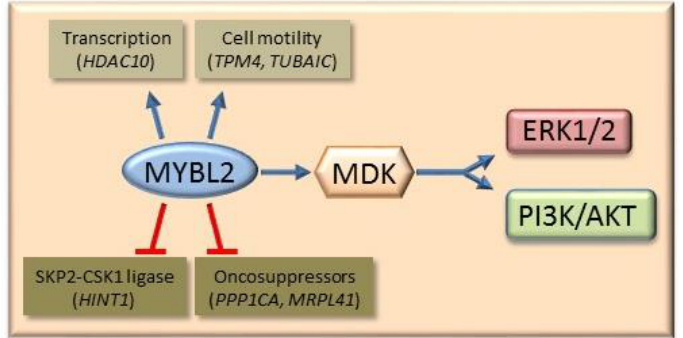
Figure 6. Oncogenic effect of MYBL2. MYBL2 activates different genes involved in DNA transcription, cell motility, and MDK (Midkine), an activator of PI3K/AKT and ERK1/2 pathways. Furthermore, MYBL2 inhibits of the SKP2-GSK1 ubiquitin ligase (Hint 1) and the oncosuppressors PPP1CA and MRPL41. Blue arrows indicate activation and blunt red arrows indicate inhibition.